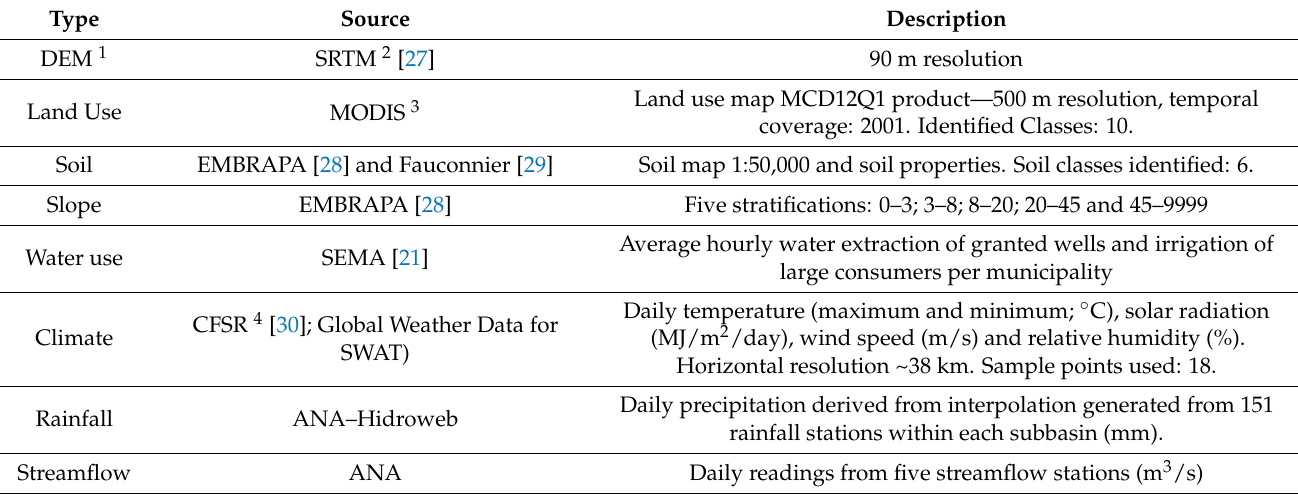
Table 1. SWAT input